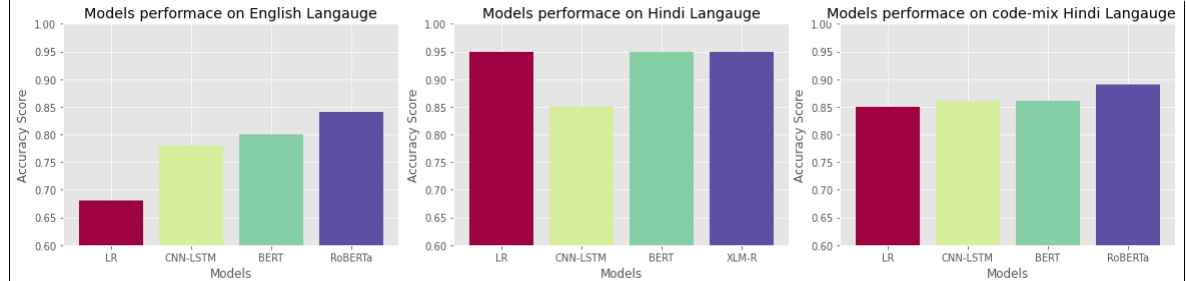
Figure 4. Our model comparison with other state-of-the-art